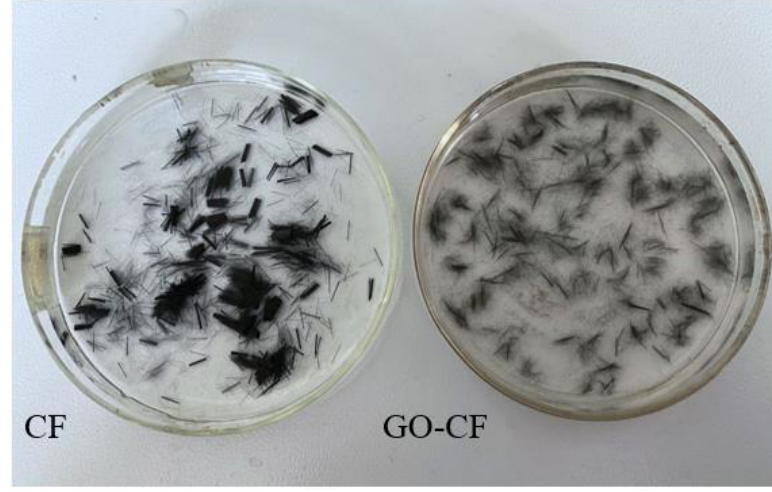
Figure 8. Dispersion of CF and GO-CF in water.